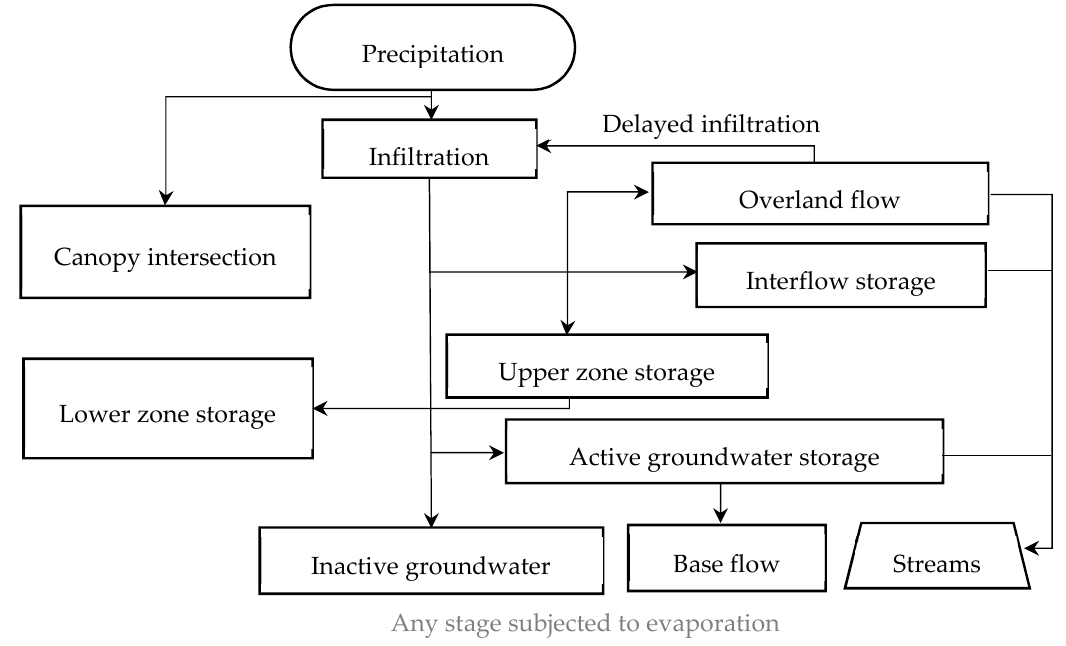
Figure 2. Water paths and storages within a watershed occurring in the pervious land used in the HSPF model.